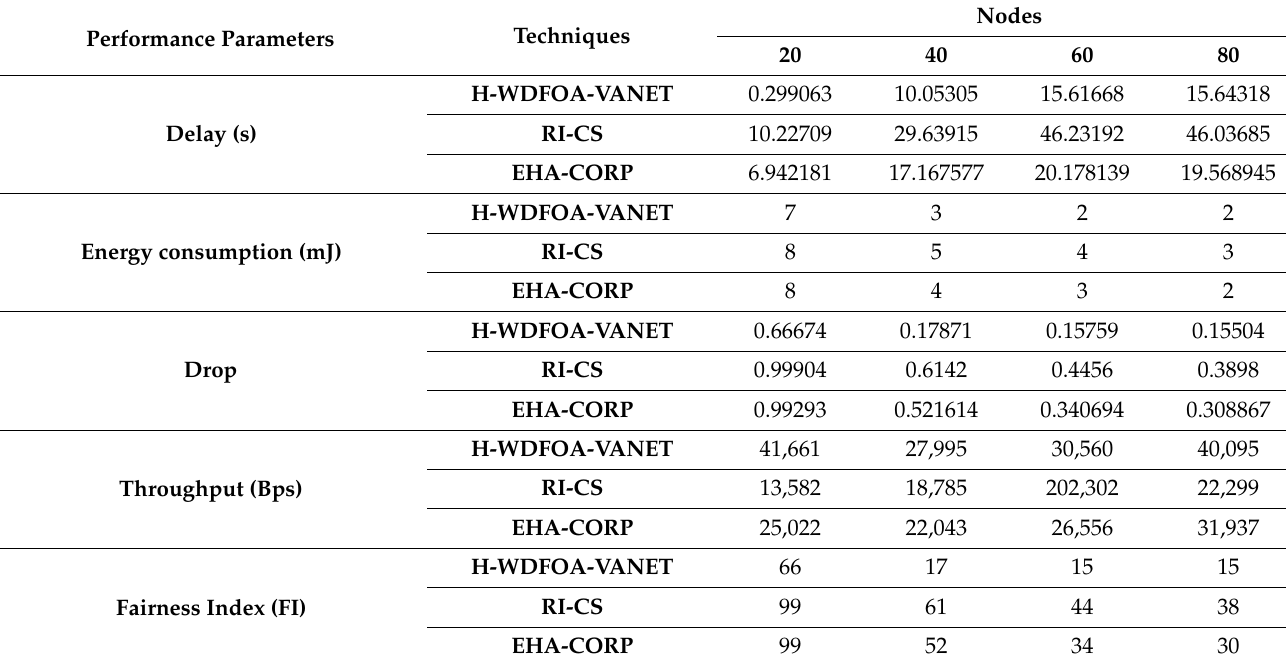
Figure 19. Plots of nodes vs. throughput in the suggested approach and existing approaches. Table 7. Comparison with existing approaches through